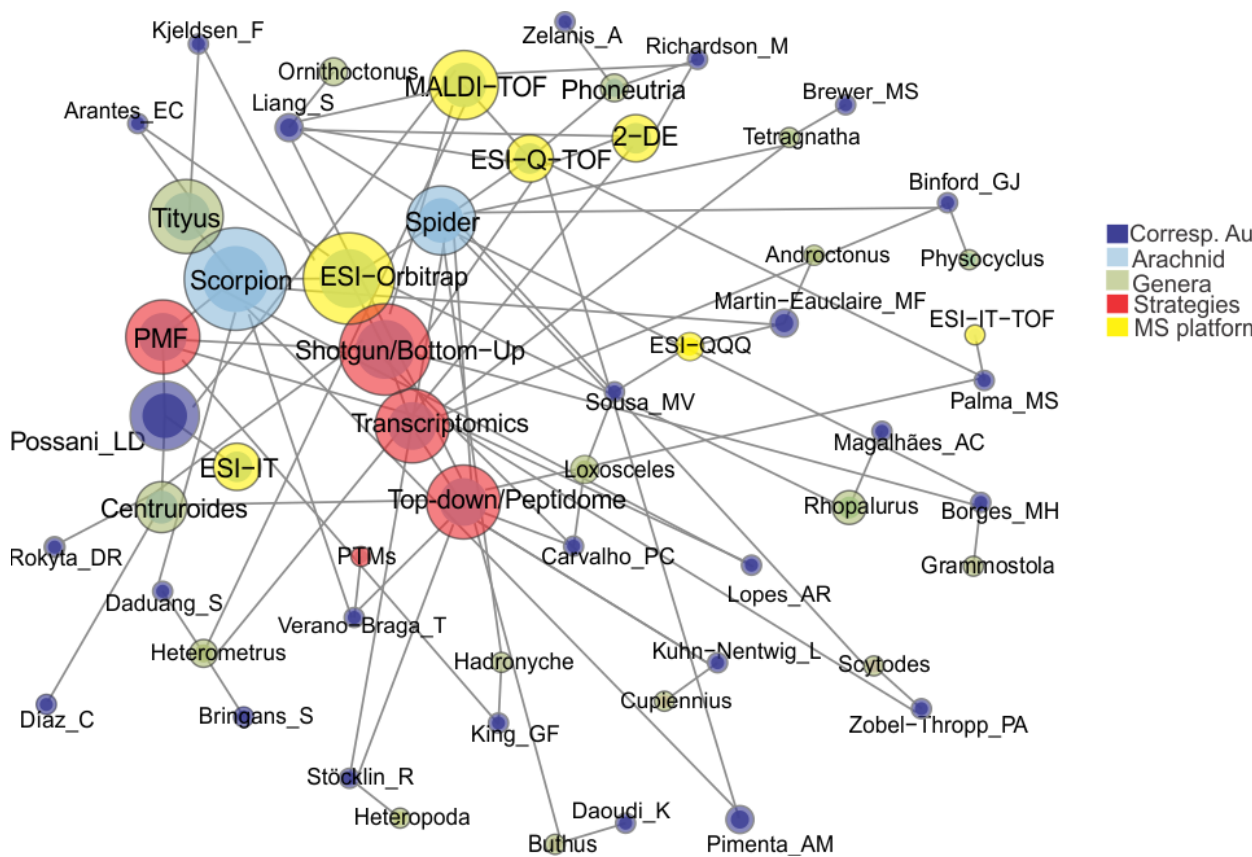
Figure 3. Summary of publications on venomics. Interaction map reporting the main terms (arachnid genera, venomic method, mass spectrometry platform, and corresponding author) found in the publications represented in this review. Node size is associated with the frequency that each term appeared in all publications.